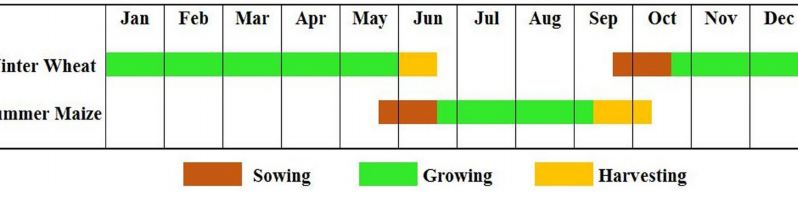
Figure 2. Phenology of crops at stations MY and GT.